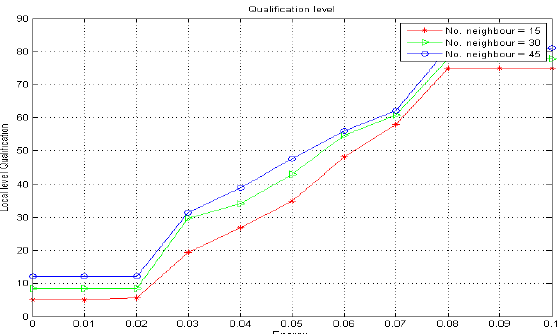
Figure 4. Analysis of Distance of Various Nodes based